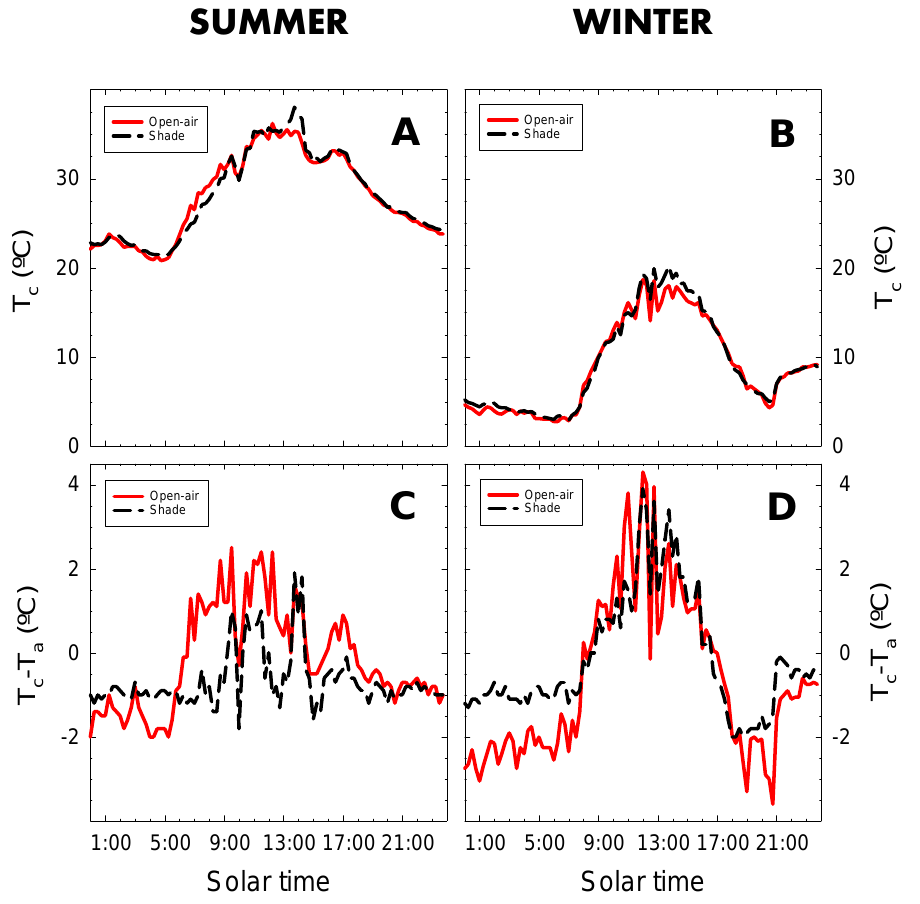
Figure 6. Diurnal course of canopy temperature (T c ) and canopy-to-air temperature di ff erence (T c − T a ) on representative days of summer (9 August 2018; A , C ) and winter (13 February 2019; B , D ) in lime trees grown in open-air (solid line) and shaded (dashed line) conditions. Lines are the 15-min average values of two replications.